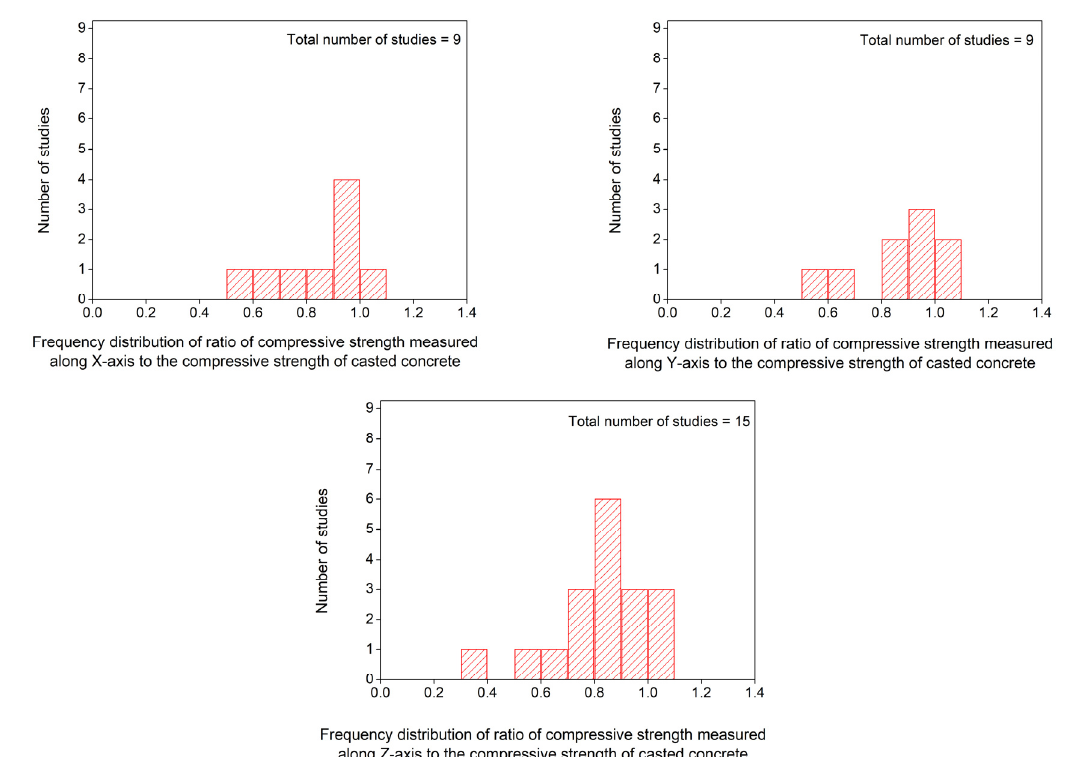
Figure 7. Anisotropy in compressive strength of 3D-printed concrete [1,49,61,92,127,135,165,175– 186].